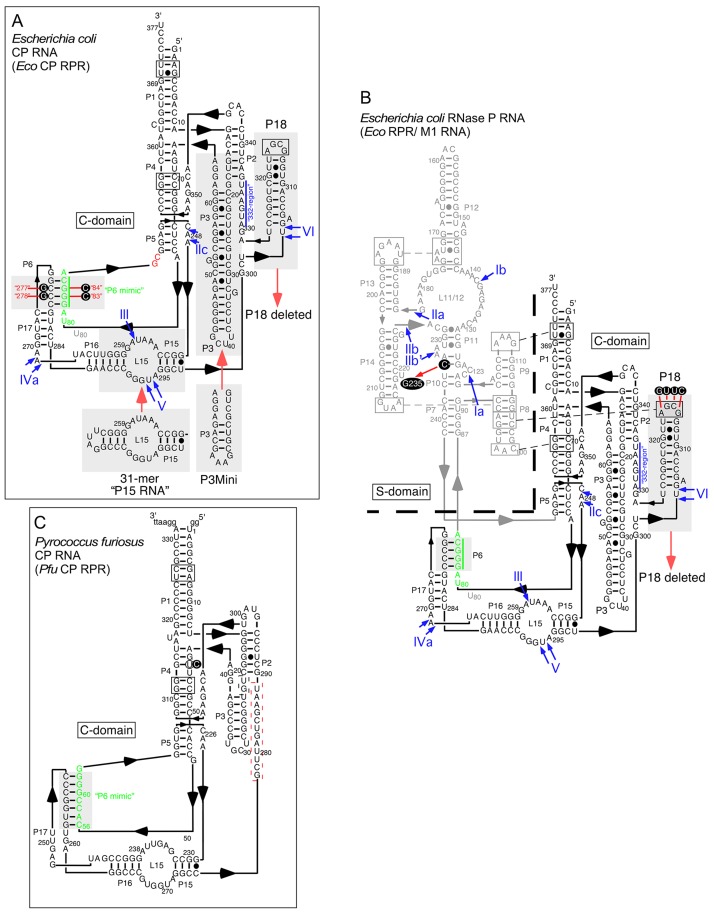
Predicted secondary structures of the type A RPRs as indicated.A. Type A Eco CP RPR [6, 46, 47], residues in green refer to residues involved in formation of the "P6-mimic" and residues highlighted (black circles) were changed as indicated: i) Eco CP RPRC83C84, Eco CP RPRG277G278 and Eco CP RPRC83C84/G277G278,. The G and C residues marked in red were added during the construction of the original Eco CP RPRwt construct (see Refs [22, 23]). Replacements marked with grey boxes and red arrows indicate: i) the 31-mer "P15 RNA" module replacement of P15-17 in Eco CP RPR31 and Eco CP RPR31delP18), ii) P3Mini module replacement of the native P3 in Eco CP RPRdelP18P3Mini and iii) deletion of P18 in Eco CP RPRdelP18, Eco CP RPR31delP18 and Eco CP RPRdelP18P3Mini. The roman numerals and arrows in blue mark the Pb2+-induced cleavage sites IIc to VI (in Fig 2B, I to VI). For convenience the "332-region" is also indicated in blue and a vertical blue line. For details see the text. B. Type A Eco RPR, the residues constituting the S-domain are shown in light gray letters and the dotted line demarcates the border separating the S- and the C-domain. Residues highlighted (black circles) were changed as indicated to generate Eco RPRP18CUUG and Eco RPRG235 while the red arrow indicate deletion of P18 generating Eco RPRdelP18. C. Type A Pfu RPR derived from Pyrococcus furiosus. On the basis of the results using Eco CP RPR residues in green refer to residues involved in formation of the "P6-mimic".